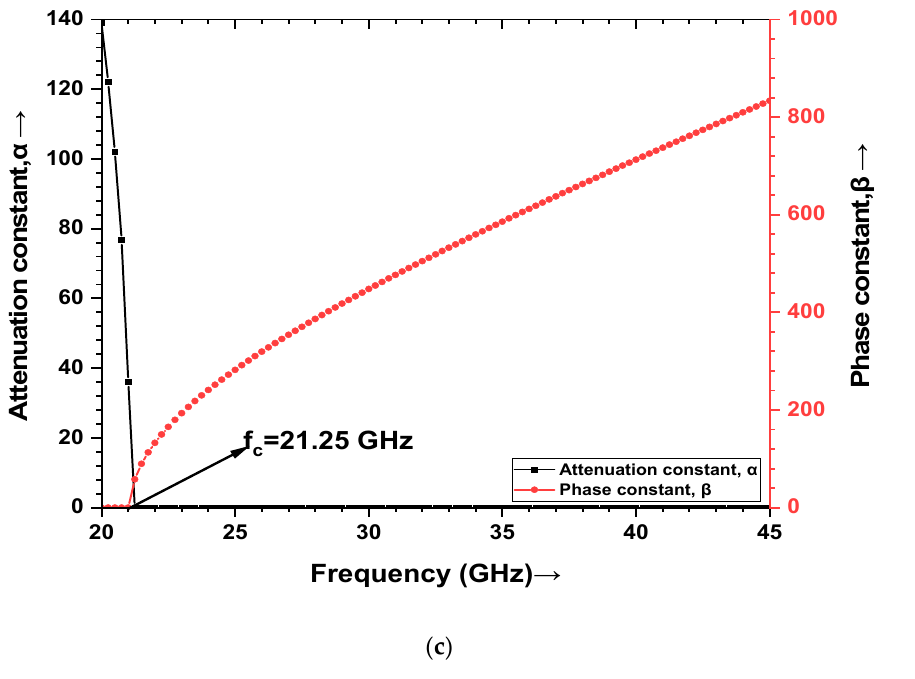
Figure 10. RWG-to-MSL transition results at 30 GHz: ( a ) IL and RL plots, ( b ) VSWR plot, and ( c ) propagation constant plots.